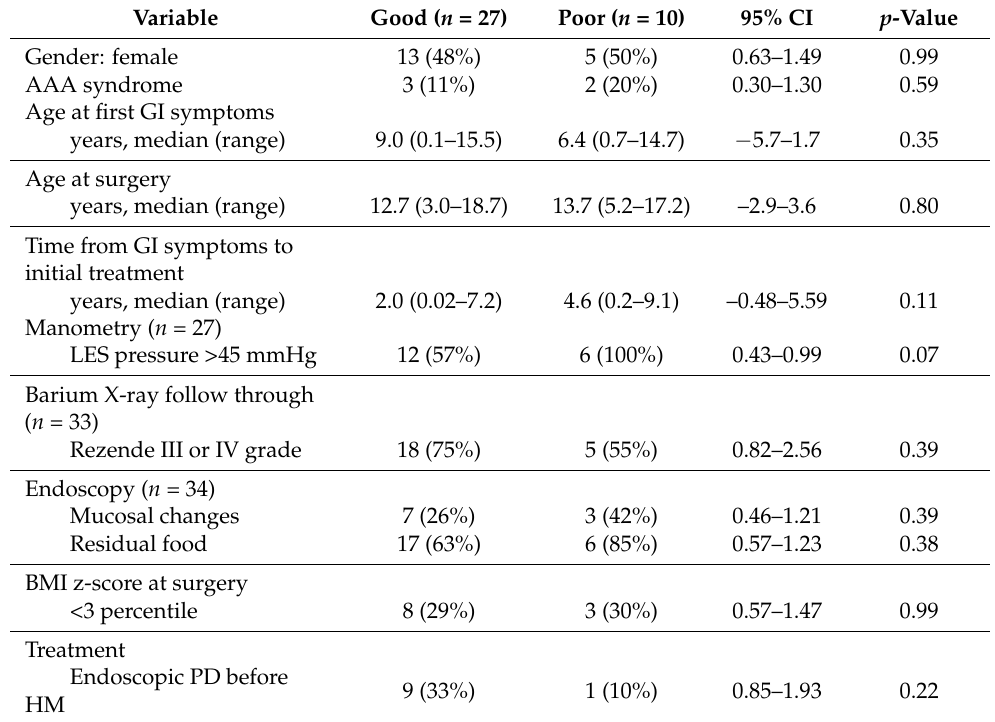
Table 4. Comparison of clinical variables between patients with good and poor outcome of HM.